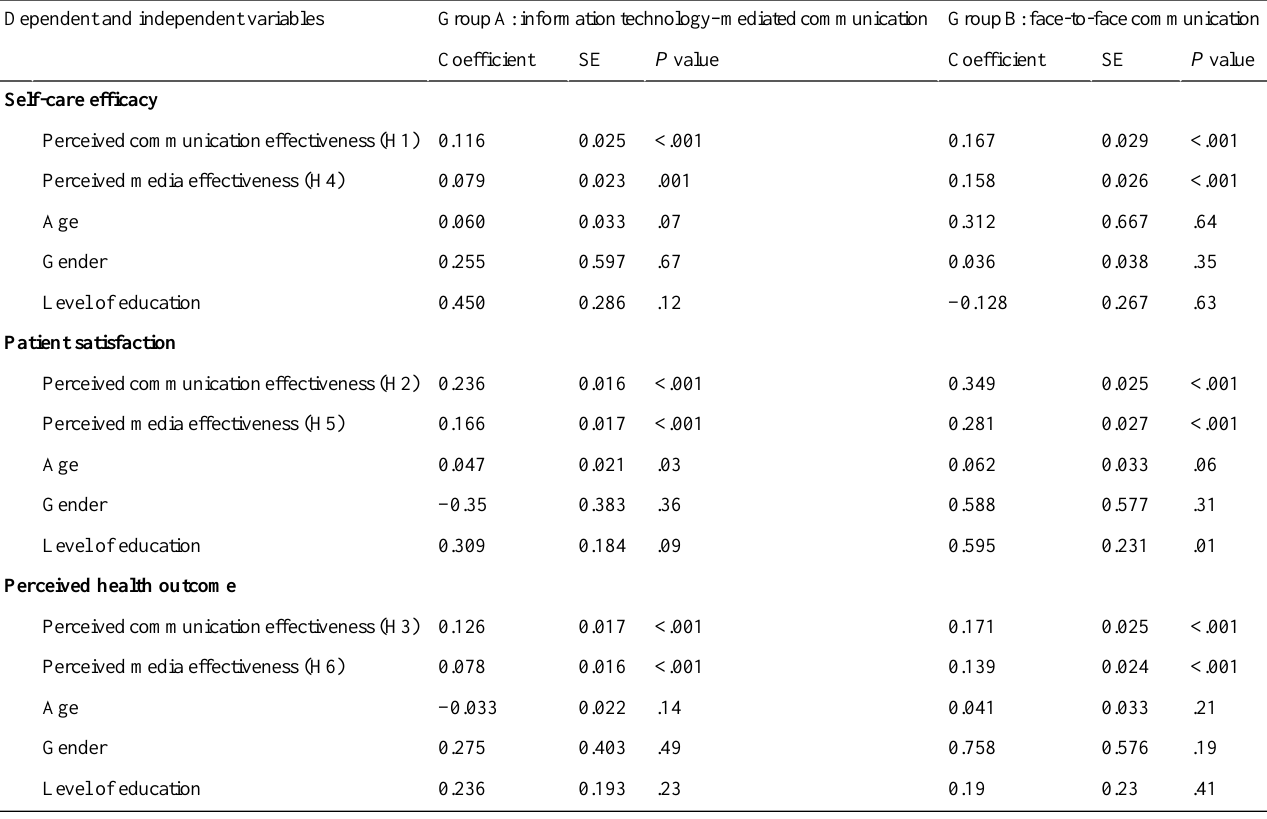
Table 2. Results for information technology–mediated communication and face-to-face communication groups.